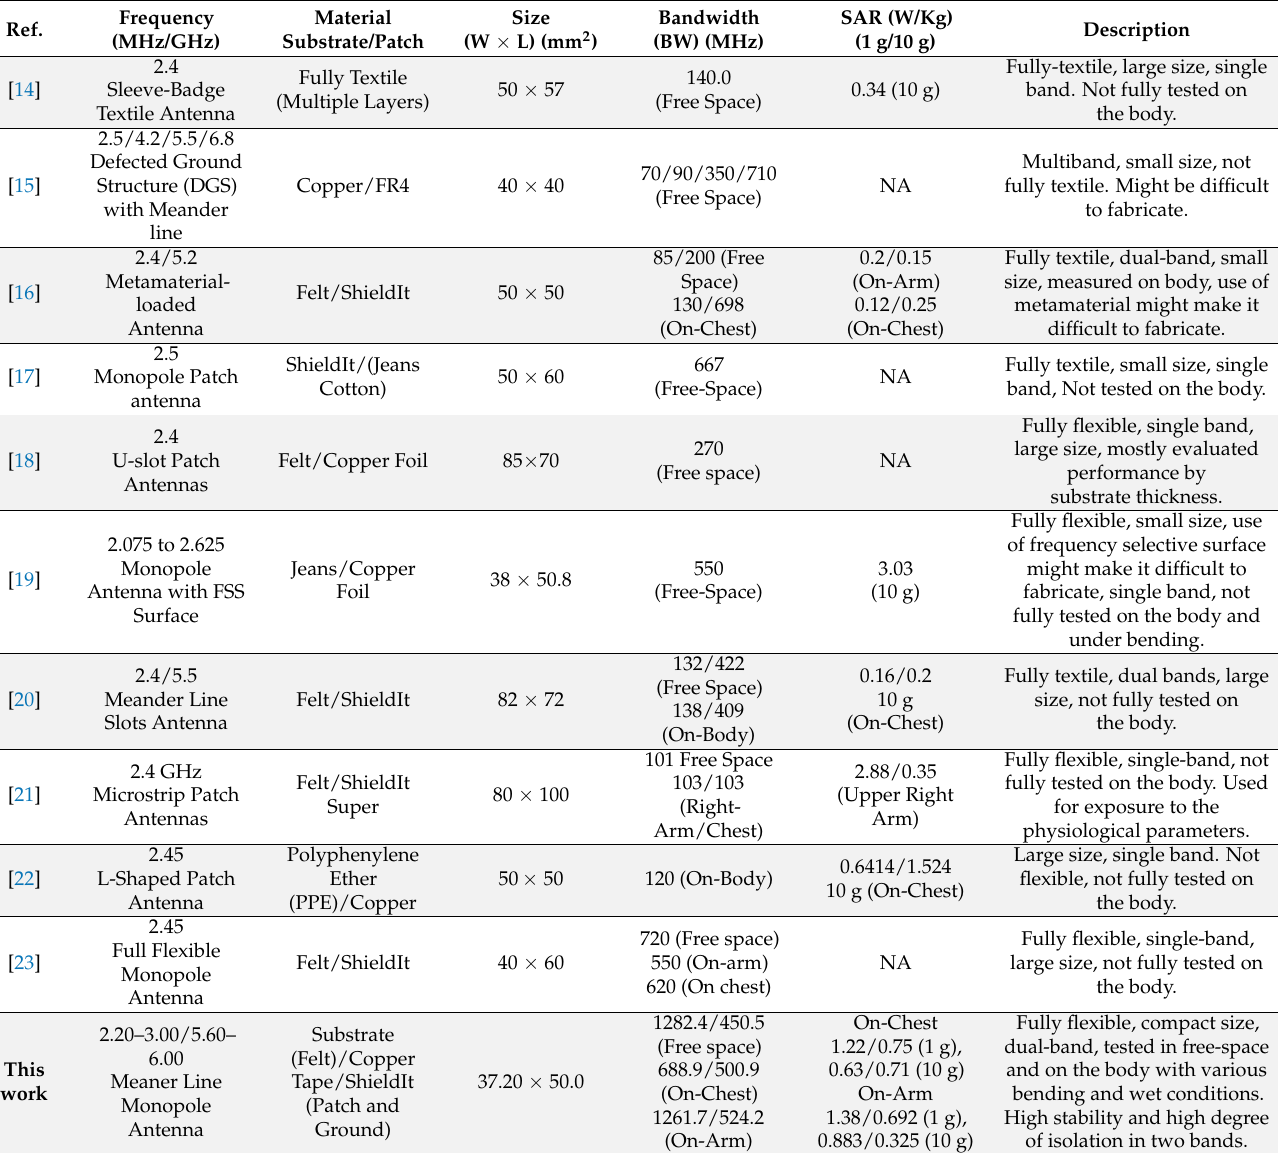
Table 1. Comparison of operating bands, materials, size, bandwidth (MHz), bending effect, and specific absorption rate (SAR) against other flexible antennas published in the literature.